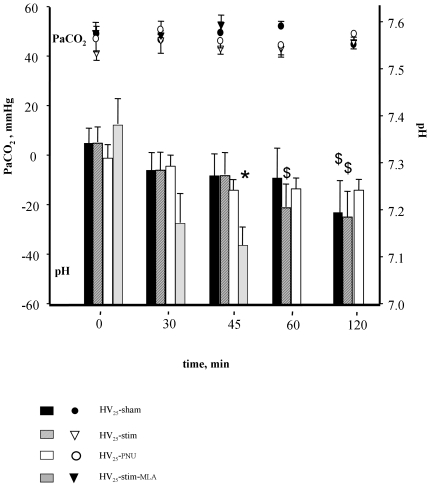
Comparative arterial blood carbon dioxide partial pressure (PaCO2, plots) and arterial pH (bars) in groups exposed to high stretch ventilation.HV25-sham: animals exposed to 25 cmH2O Paw only. HV25-stim: animals exposed to 25 cmH2O Paw and receiving vagal stimulation. HV25-stim/MLA, vagal stimulation was associated to a pre-treatment with a specific antagonist of the alpha7 nicotinic acetylcholine receptor, methyllycaconitine (MLA). HV25-PNU: animals exposed to 25 cmH2O Paw and pre-treated with the alpha7 nicotinic acetylcholine receptor agonist PNU. Symbol $ indicates significant differences versus baseline in a same group. Symbol * indicates significant differences versus HV25-sham group at the same time.